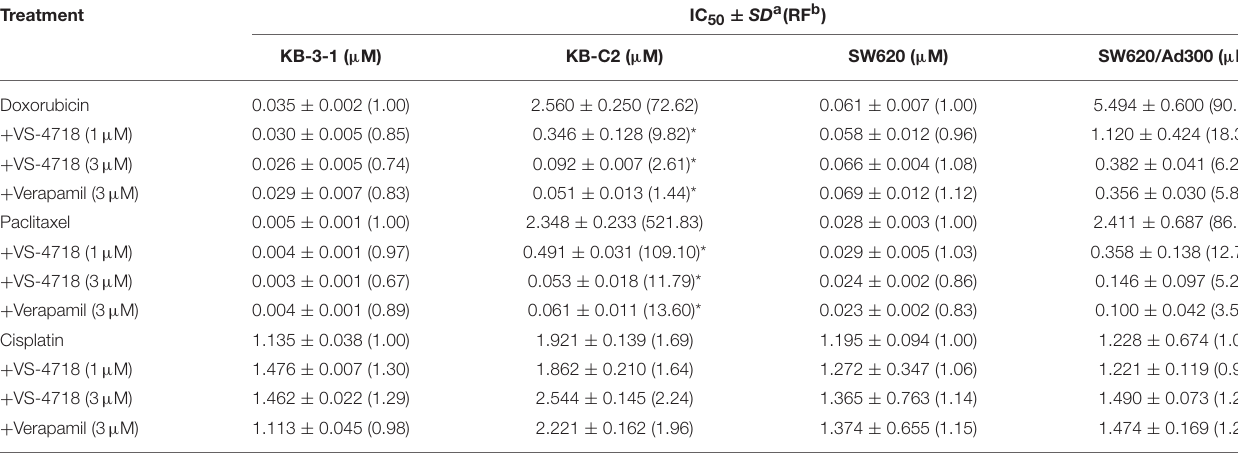
TABLE 1 | VS-4718 sensitized ABCB1-substrate-selected resistant cells to ABCB1 substrates. Treatment